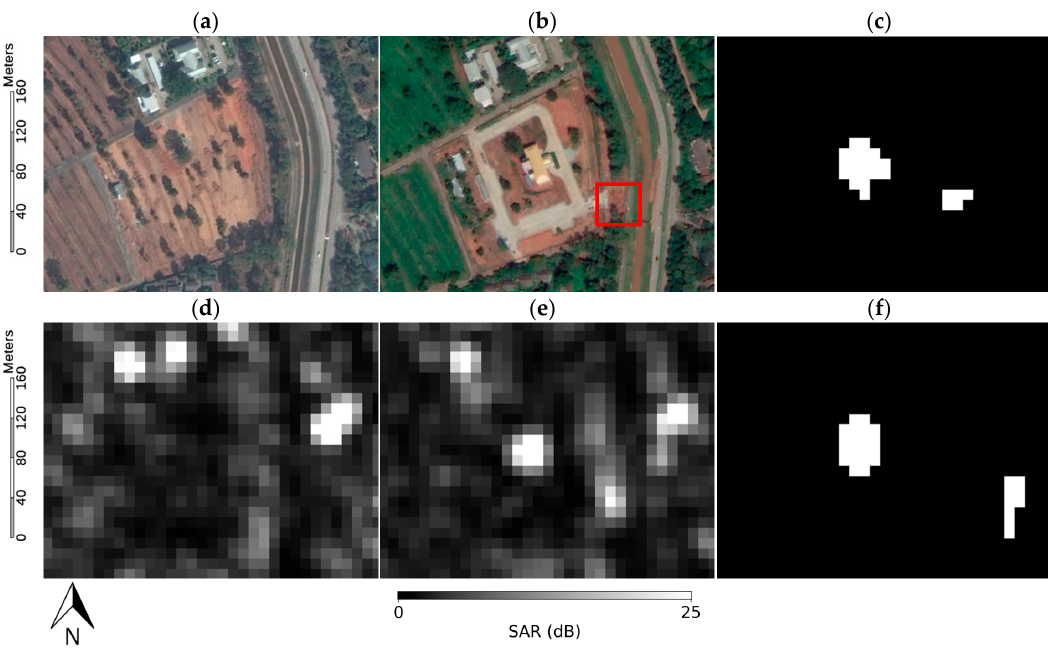
Figure 15. Detection results of the second area in Chiang Mai at 18°51’22.36”N 98°57’40.70”E. The size of each image is 0.32 × 0.23 km. ( a ) Time 1 optical data; ( b ) Time 2 optical data; ( c ) result of CORN; ( d ) Time 1 SAR data ‘Copernicus Sentinel data [2015]’; ( e ) Time 2 SAR data ‘Copernicus Sentinel data [2017]’; ( f ) result of U-net. Remote Sens. 2020 , 12 , x FOR PEER REVIEW